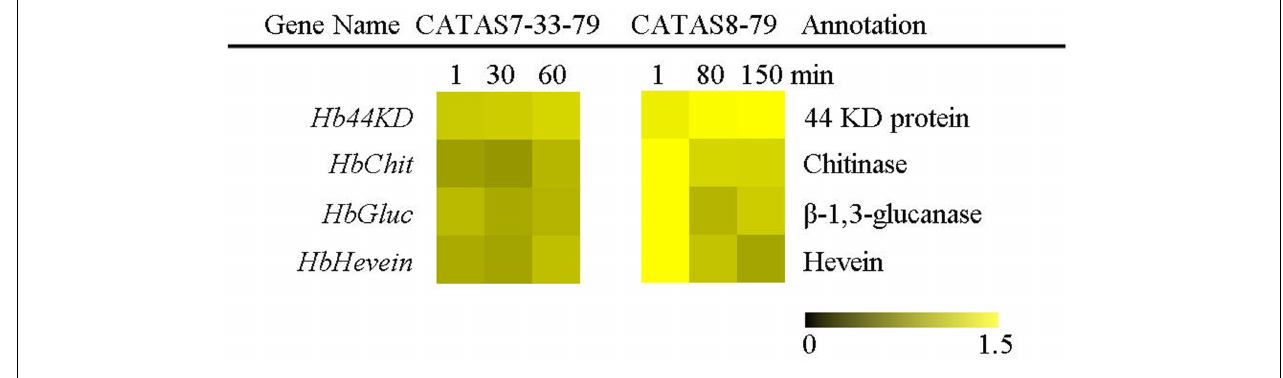
FIGURE 7 | The qRT-PCR analysis of latex coagulation related genes across three stages of latex flow between CATAS7-33-97 and CATAS8-79.